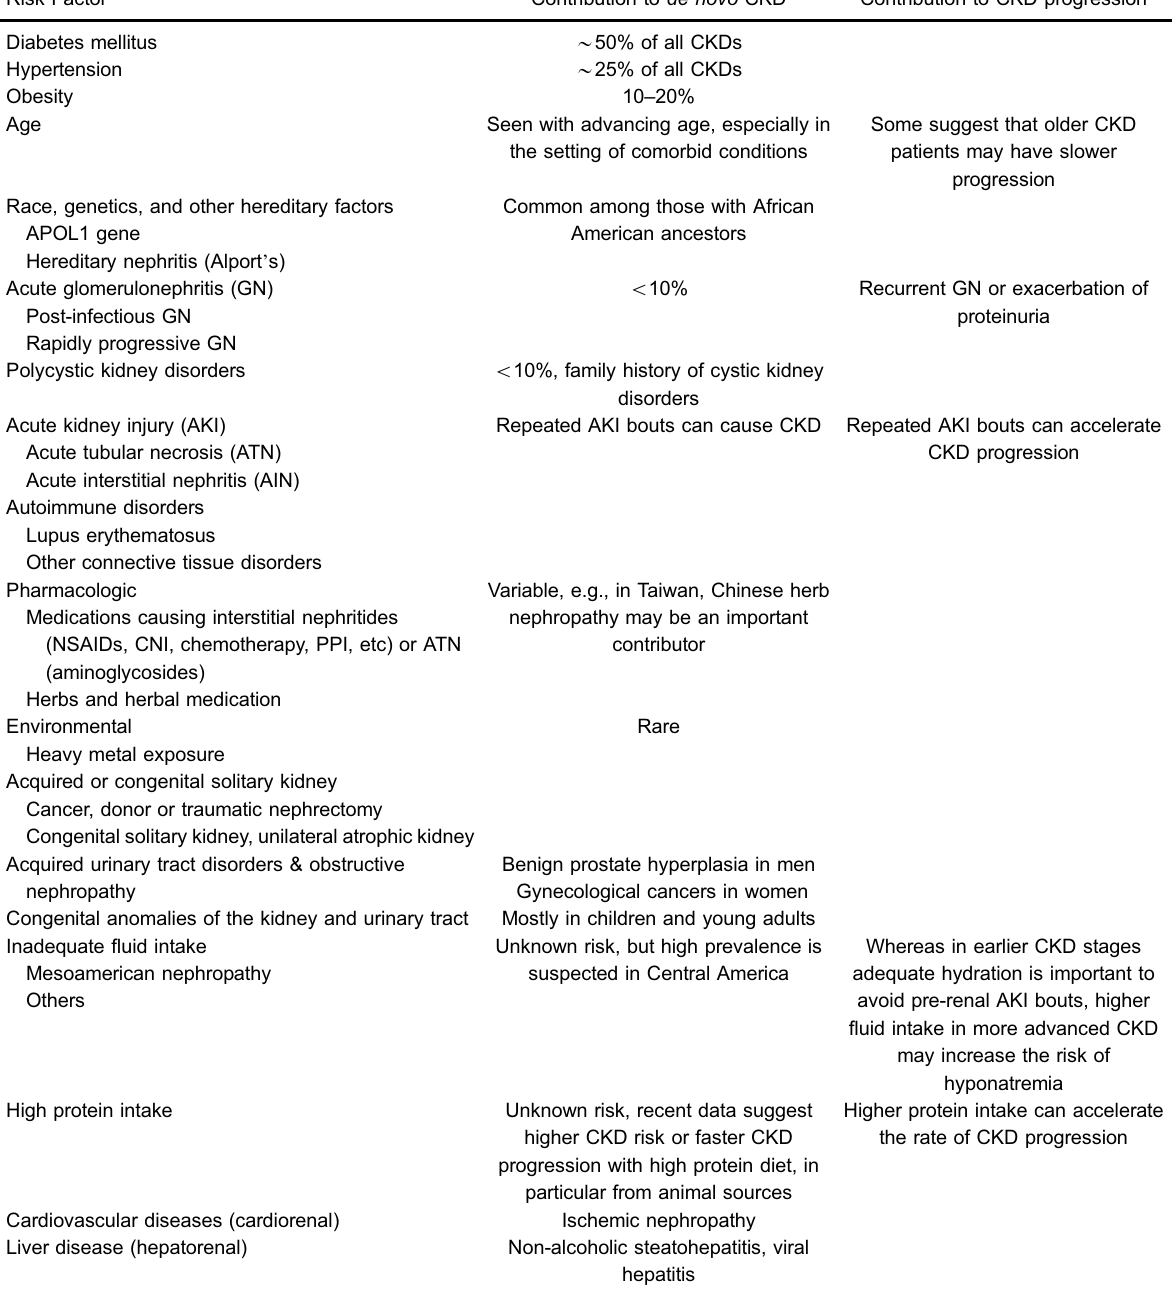
Table 1. Risk factors for de novo chronic kidney disease (CKD) and pre-existing CKD